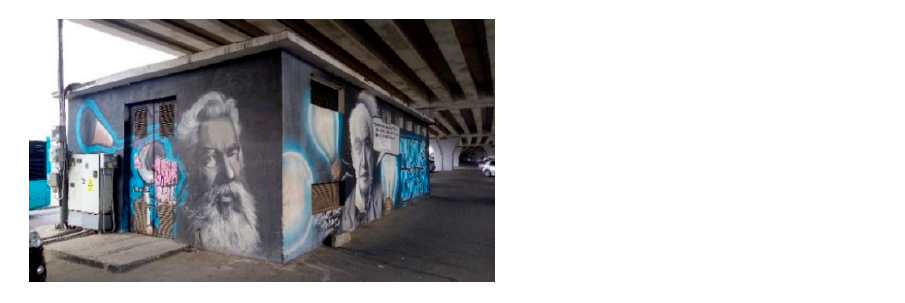
Figure 32. Aurel Vlaicu, Kiseleff Park, Bucharest by Fear and Suflo, 2014 (photo taken in 2017).